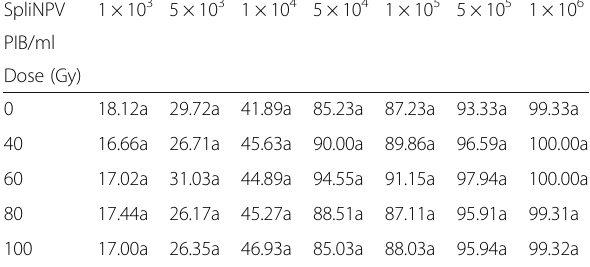
Table 1 Concentration-mortality response of neonate Spodoptera littoralis larvae resulted from mated females with irradiated males as pupae followed by SpliNPV treatments